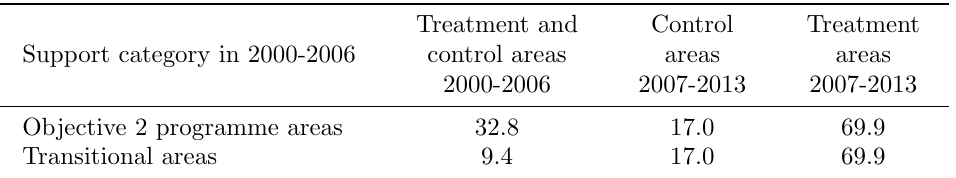
Table 1: ERDF support intensity (EUR/capita/year) in treatment and control areas, 2000-2006 and